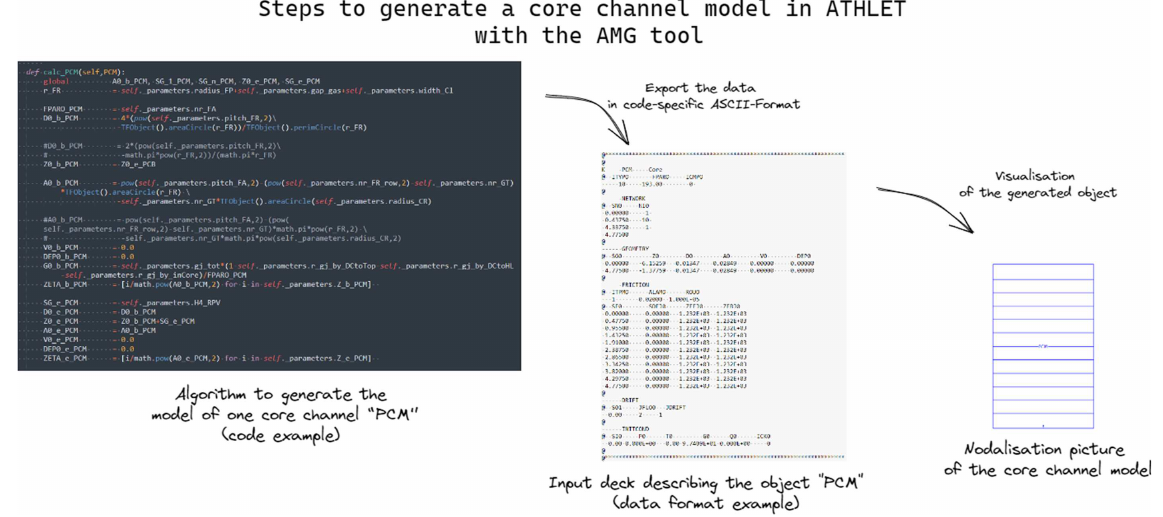
Fig. 8. Steps to generate one core channel model in ATHLET with the AMG